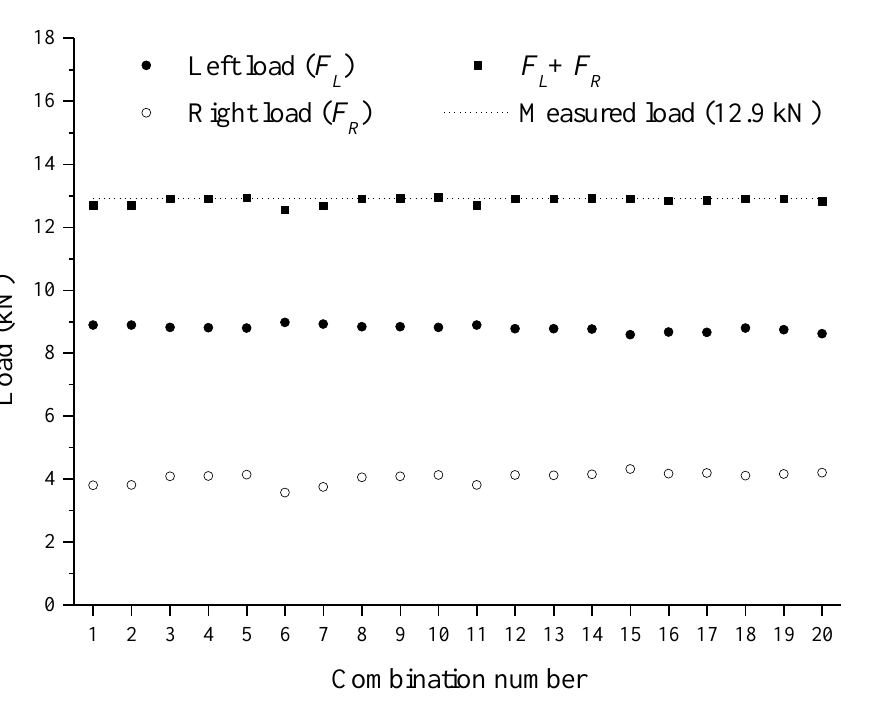
Figure 8. Identified loads according to 20 combinations (loading step